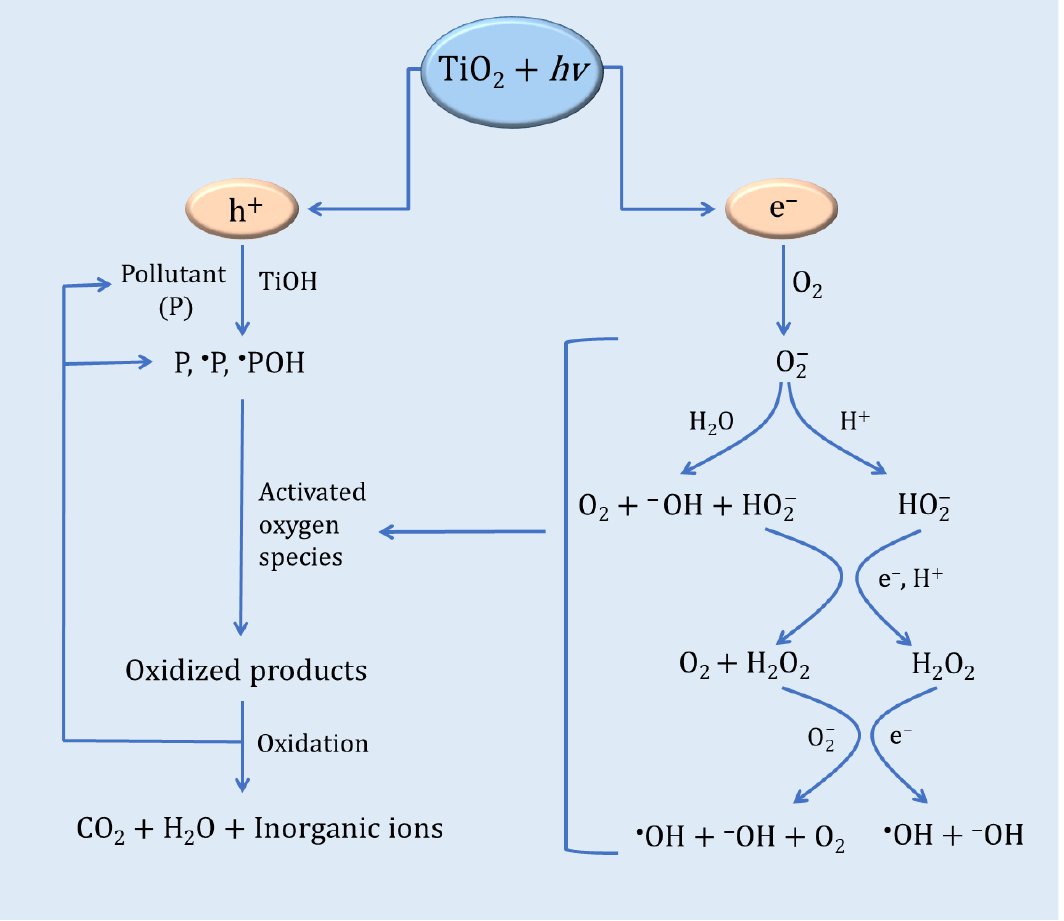
Figure 4. Photocatalytic degradation process utilizing TiO 2 . Adapted with permission from ref. [115] Copyright© 2022 American Chemical Society.